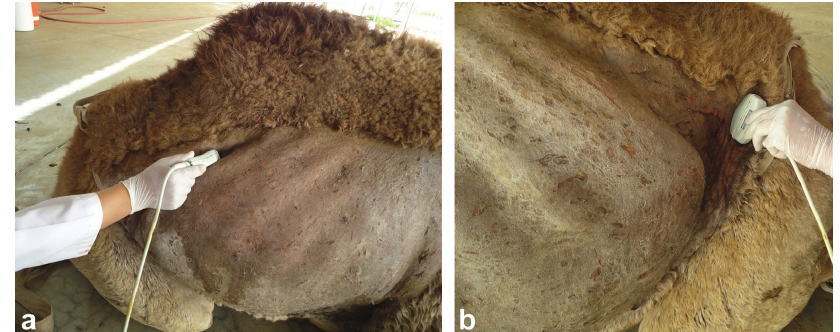
Figure 4: Imaging of the right kidney in the upper right flank (a) and the left (b) kidney in the caudal part of the left